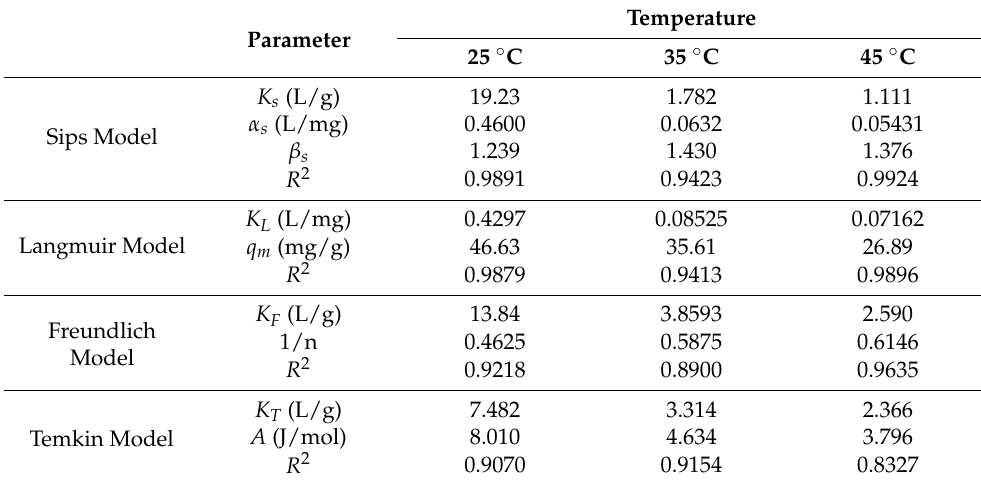
Table 3. Adsorption isotherm parameters for the adsorption of 4 −